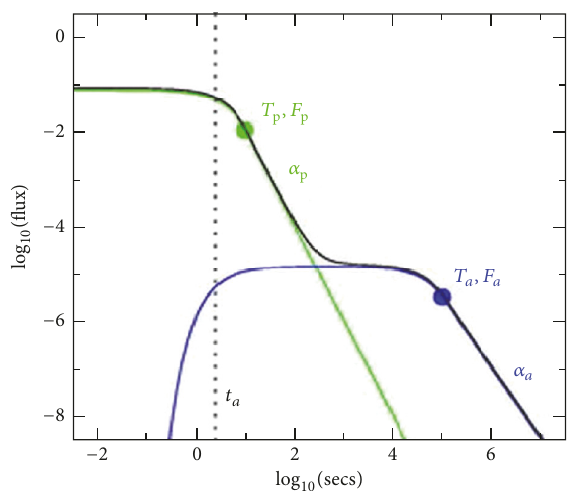
Figure 13: Functional form of the decay and the fitted parameters. The prompt component (green curve) has no rise because time zero is set at the peak. The afterglow component (blue curve) rises at time 𝑇 𝑎 as shown. (Figure after Willingale et al. [81]; see Figure @ AAS. Reproduced with